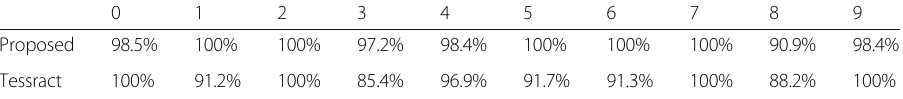
Table 2 The accuracy rates of each digit for the proposed system and the Tesseract OCR software 0